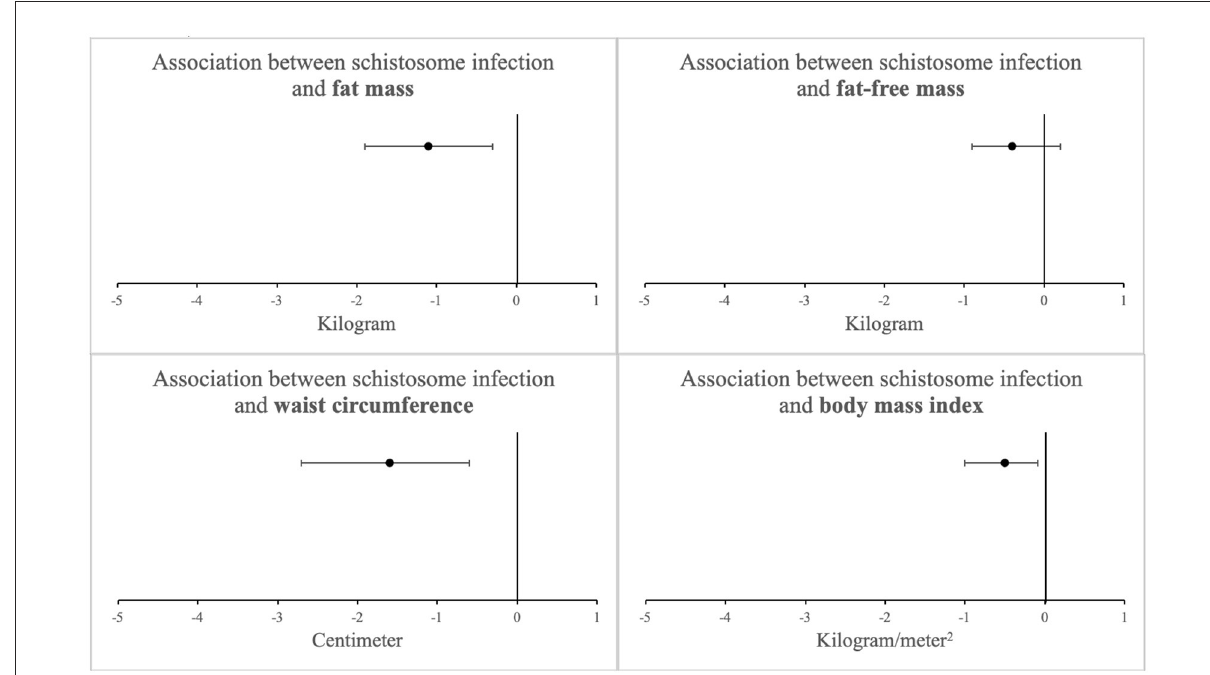
FIGURE1 Association between schistosome infection and measures of adiposity among 1923 study participants after adjusting for potential confounders (linear regression coefficients with 95% confidence intervals) a . a Adjusted for age, sex, physical activity, tobacco use, education level, and socioeconomic status, No significant interaction was observed by HIV status (see Table